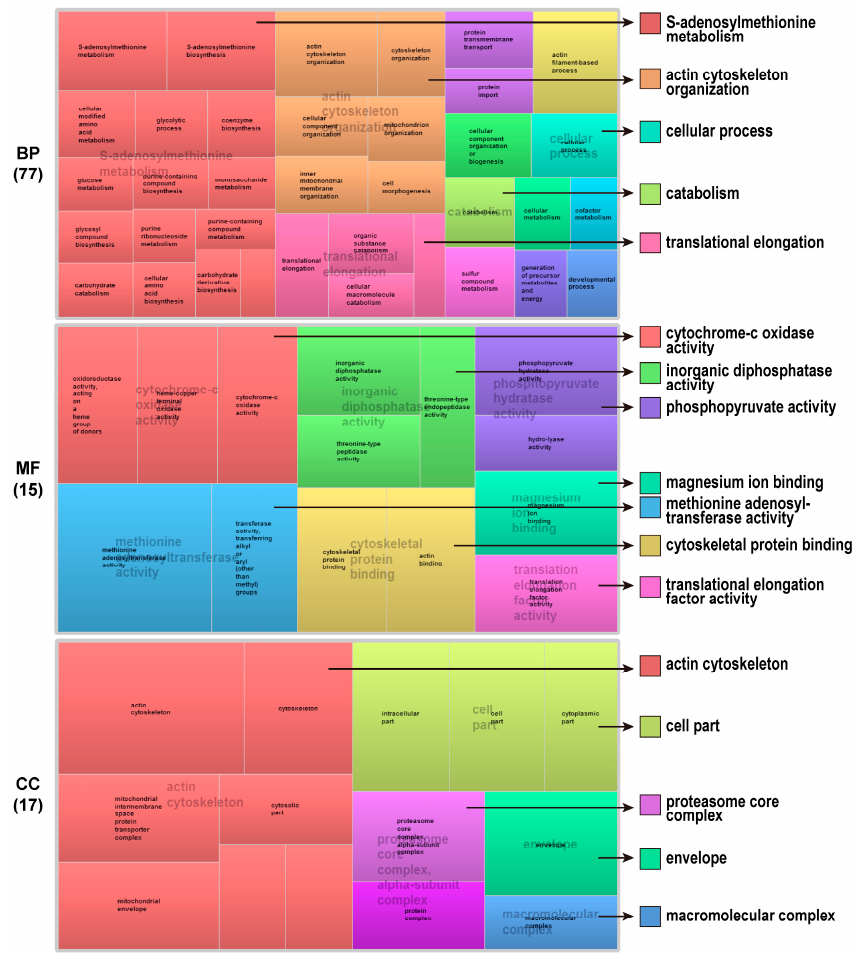
Figure 4. GO treemaps for the DEPs in ‘ZH1’ and ‘ZH2’ pollen. GO terms for proteins identified in ‘ZH1’ and ‘ZH2’ pollen are shown. The box size correlates to the − log10 P -value of the GO term. Boxes with the same color can be grouped together and correspond to the same upper-hierarchy GO-term.